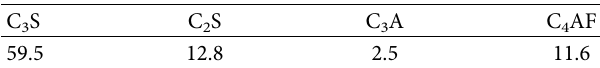
Table 2: Mineralogical composition (%) of the cement